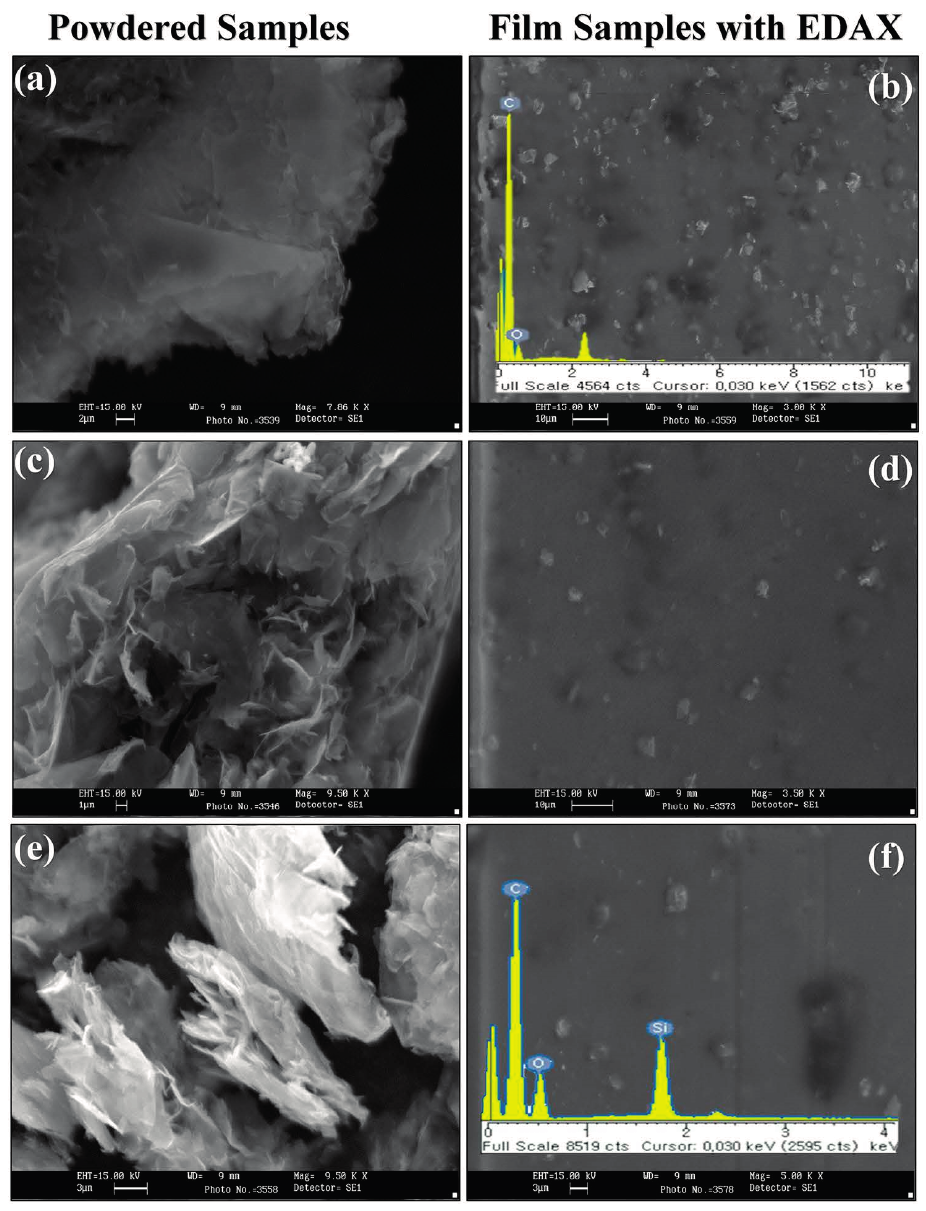
Figure 8. SEM–EDAX of powdered composite and the film. ( a , b ) GR/CS; ( c , d ) o-GR/CS and ( e , f ) f-GR/CS composite